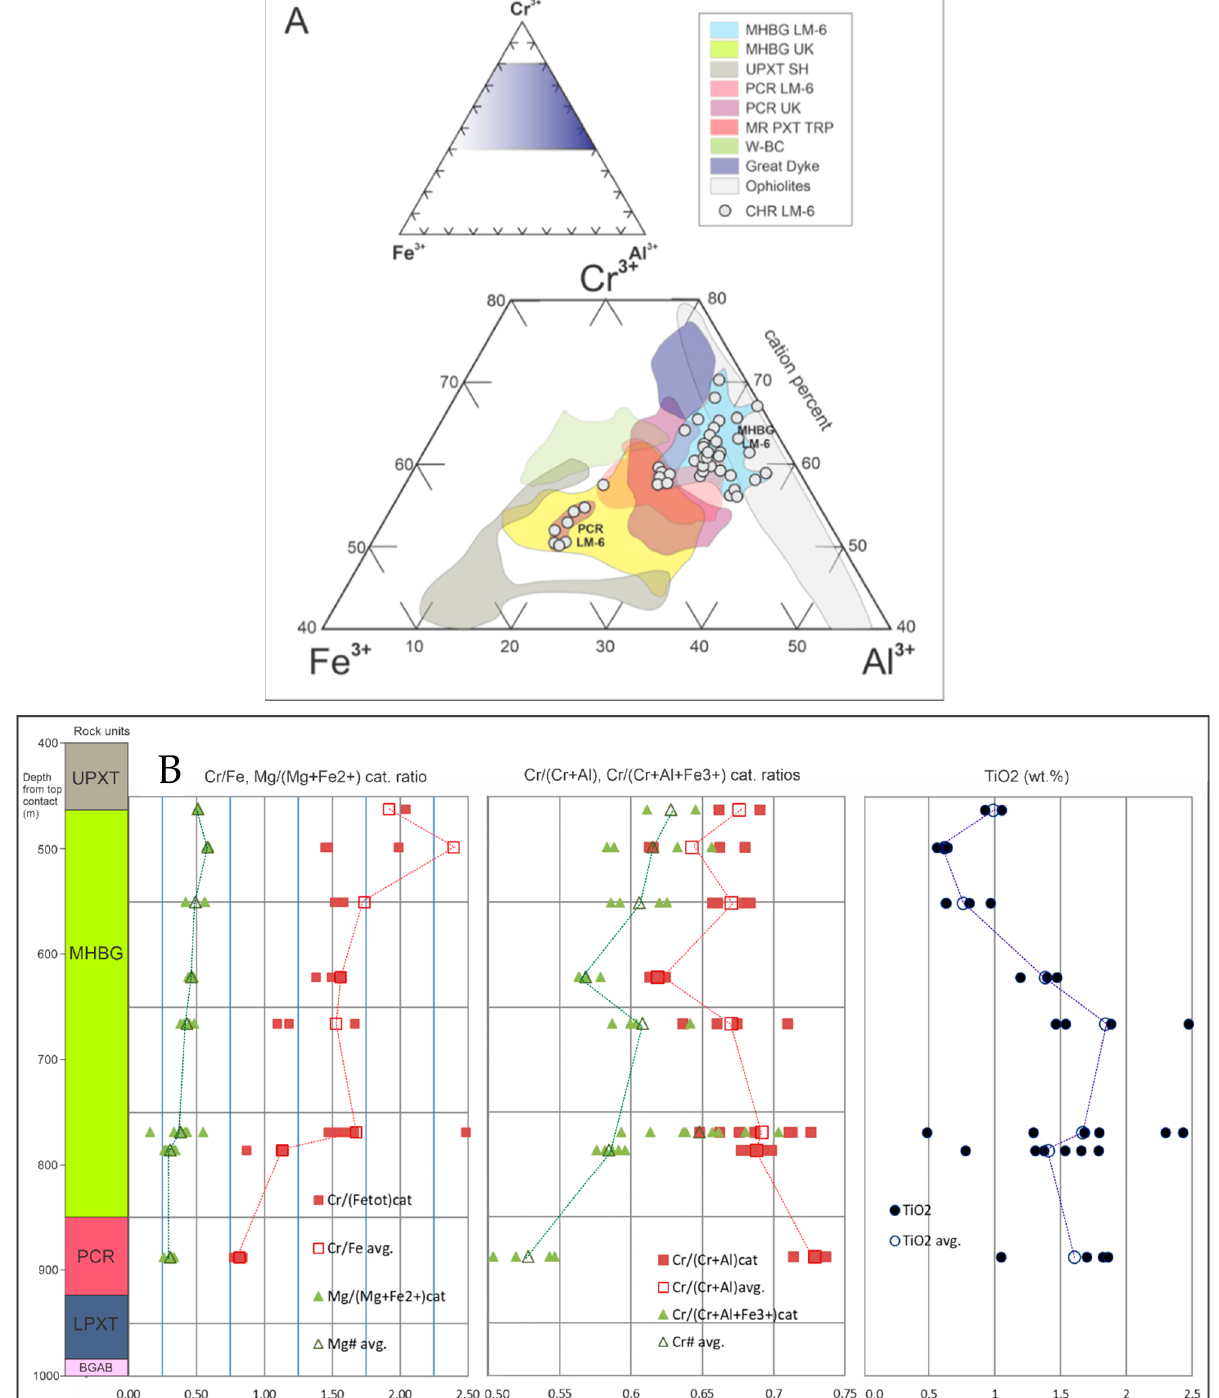
Figure 12. LM-6 Main Harzburgite and Chromitiferous Harzburgite chromite compositions in comparison with UK/SH and Bushveld Complex chromite data ( A ). Abbreviations of rock units as in Figure 5, MR PXT TRP: Chromites of Merensky Reef pyroxenite unit, Two Rivers Platinum Mine, W-BC: Merensky Reef unit, Western Bushveld. ( B ) average values and variation trends of Cr/Fe, Mg/(Mg+Fe 2+ ), Cr/(Cr+Al), Cr/(Cr+Al+Fe 3+ ) cation ratios and TiO 2 contents (wt %) in chromite from Uitkomst chromitites within the LM-6 stratigraphic section.